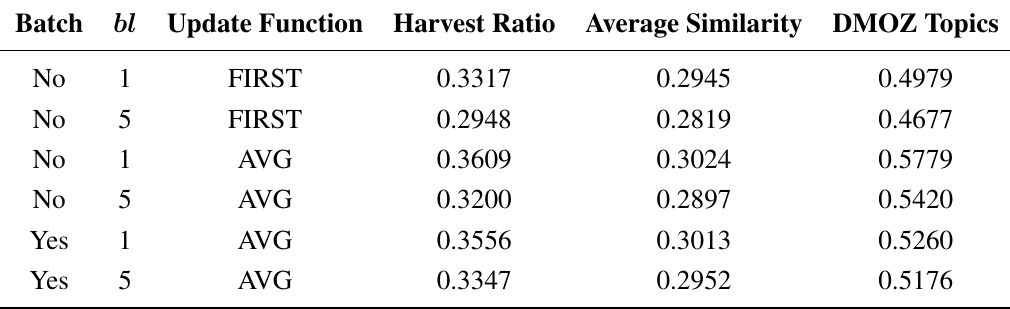
Table 2. Results from simulated crawls with and without batch priority